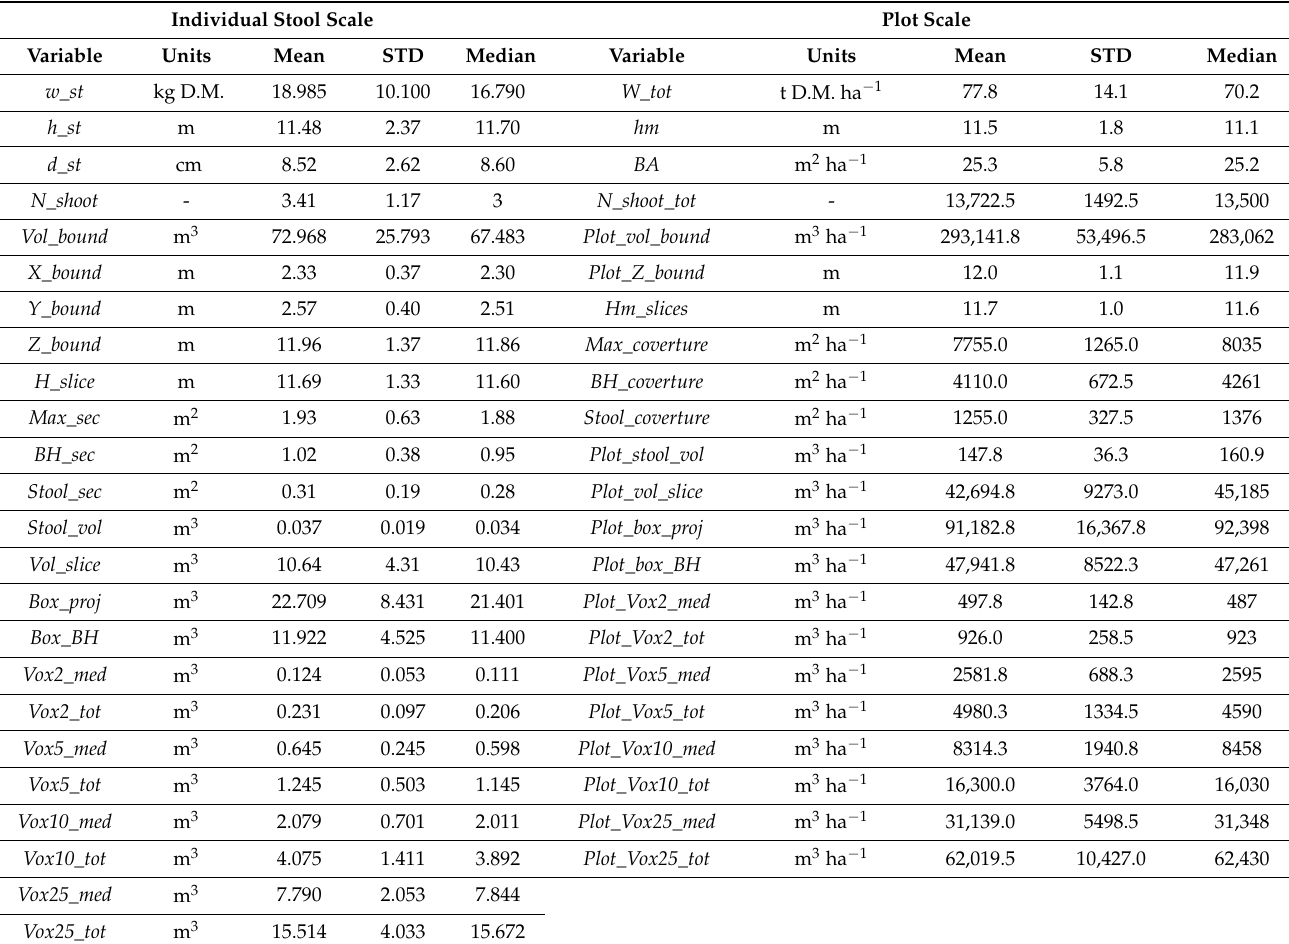
Table 3. Mean values and standard deviations for the different dendrometric and TLS